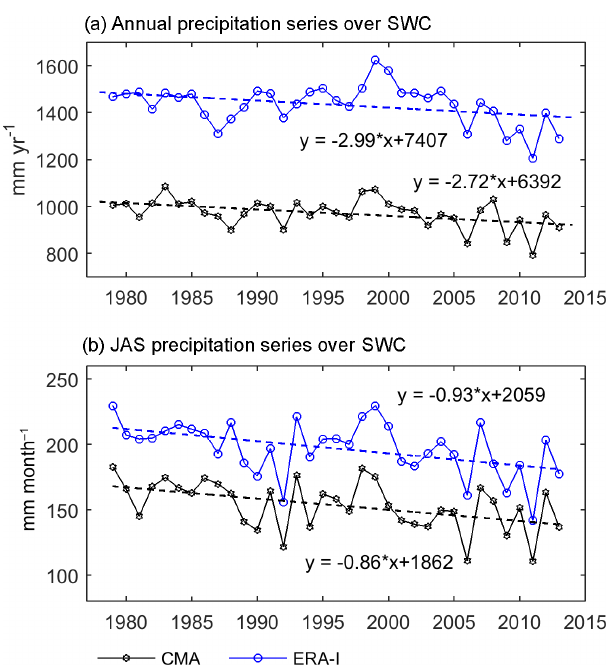
Figure 2. The time series of (a) annual and (b) July, August, and September (JAS) SWC precipitation from 1979 to 2013 with ERA-I (blue line) and CMA (black line) data. The trends are all significant at the 5% level based on the two-tailed Student’s t